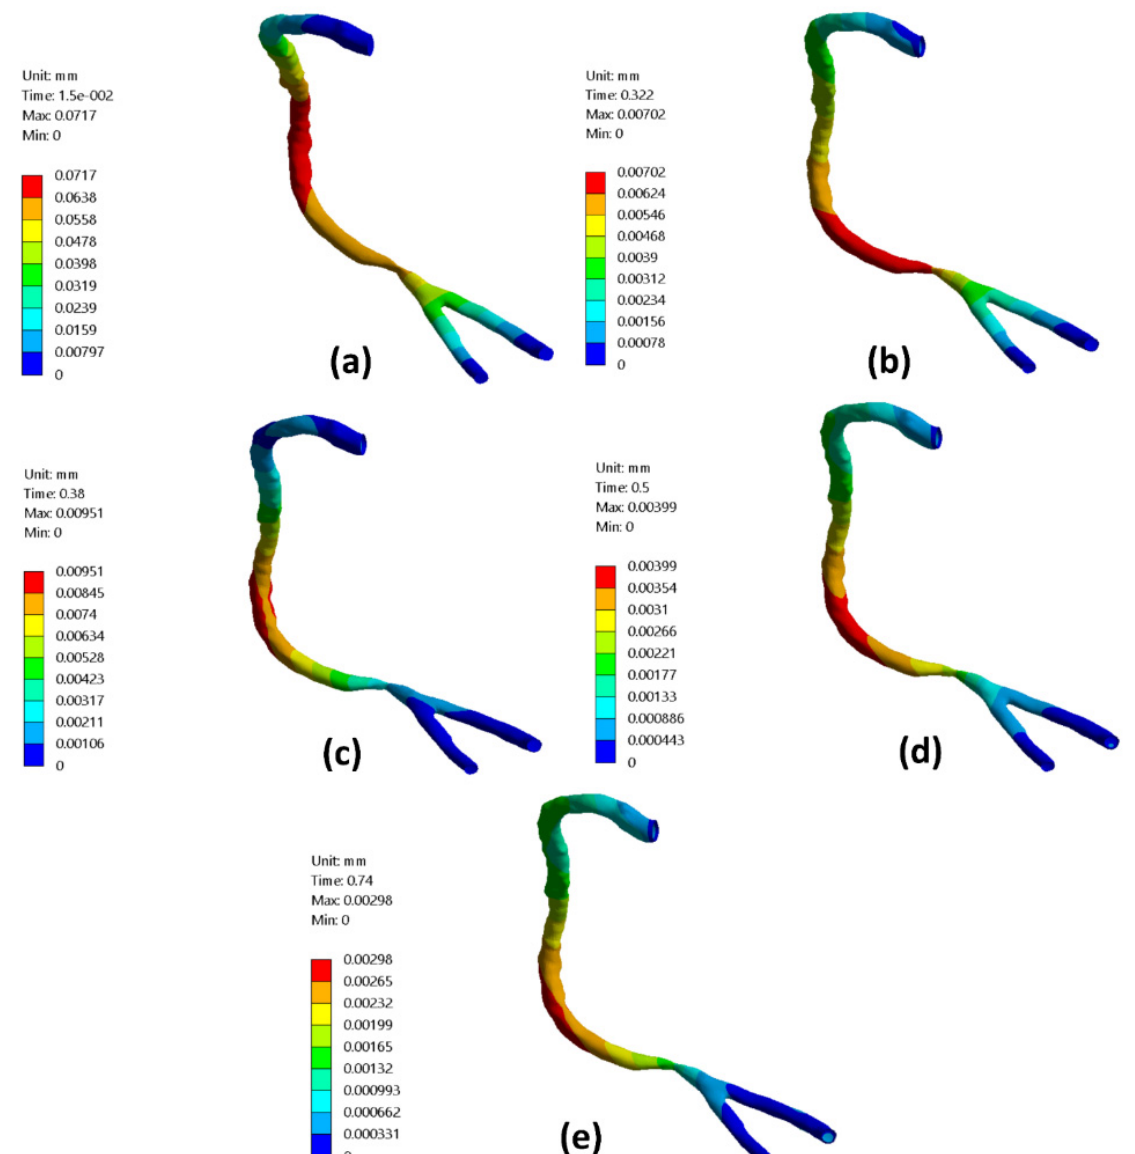
Figure 10. RCA—model A deformation contours for different times of the cardiac cycle: ( a ) t = 0.015 s, ( b ) t = 0.32 s, ( c ) t = 0.38 s, ( d ) t = 0.5 s, and ( e ) t = 0.74 s.